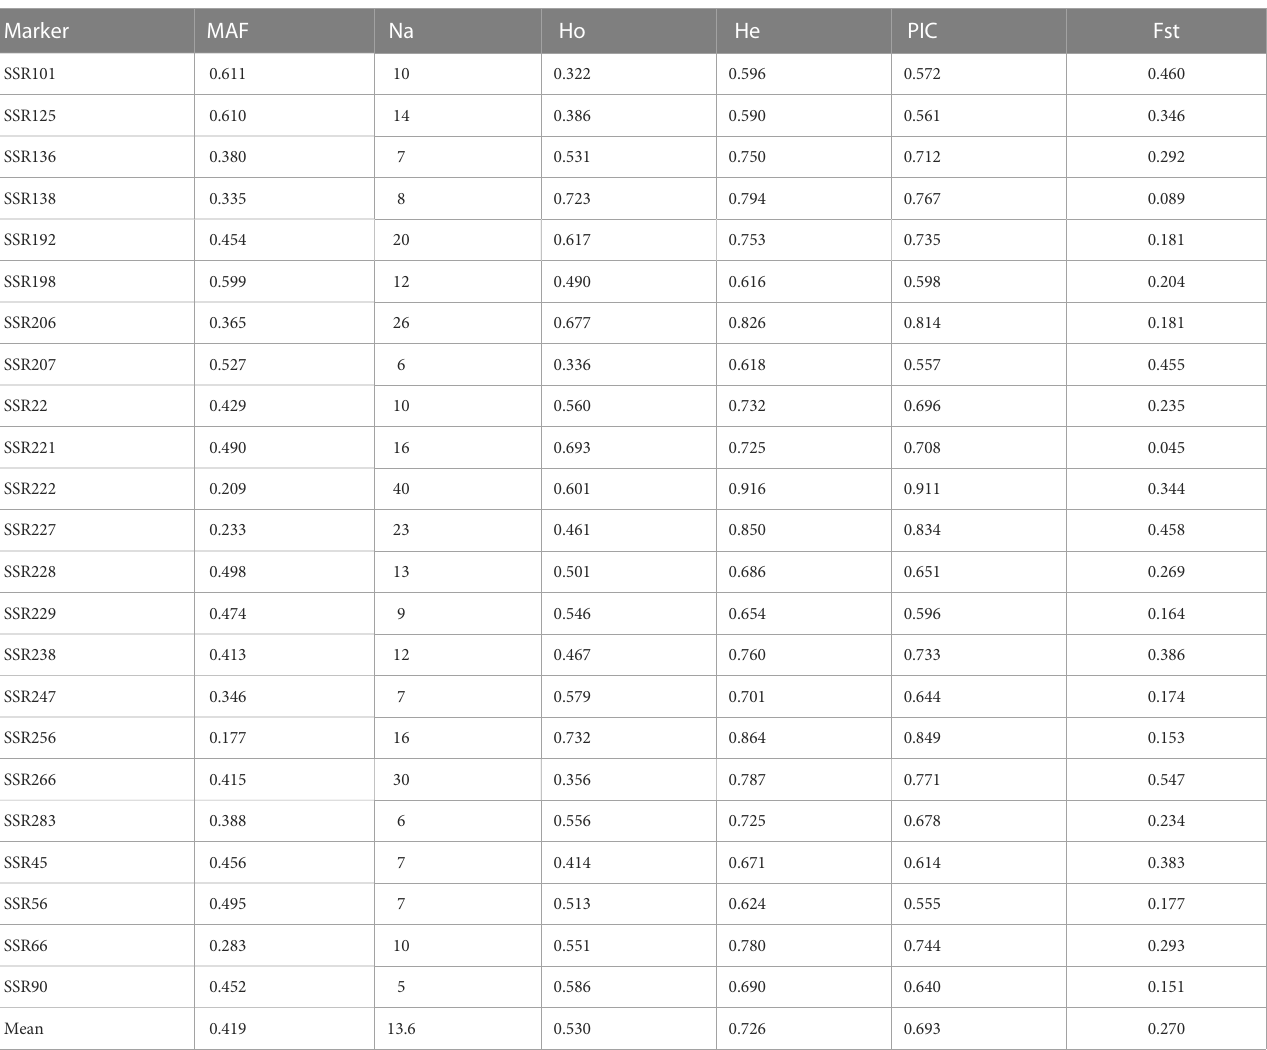
TABLE 3 Genetic parameters of the 23 SSR markers. Marker